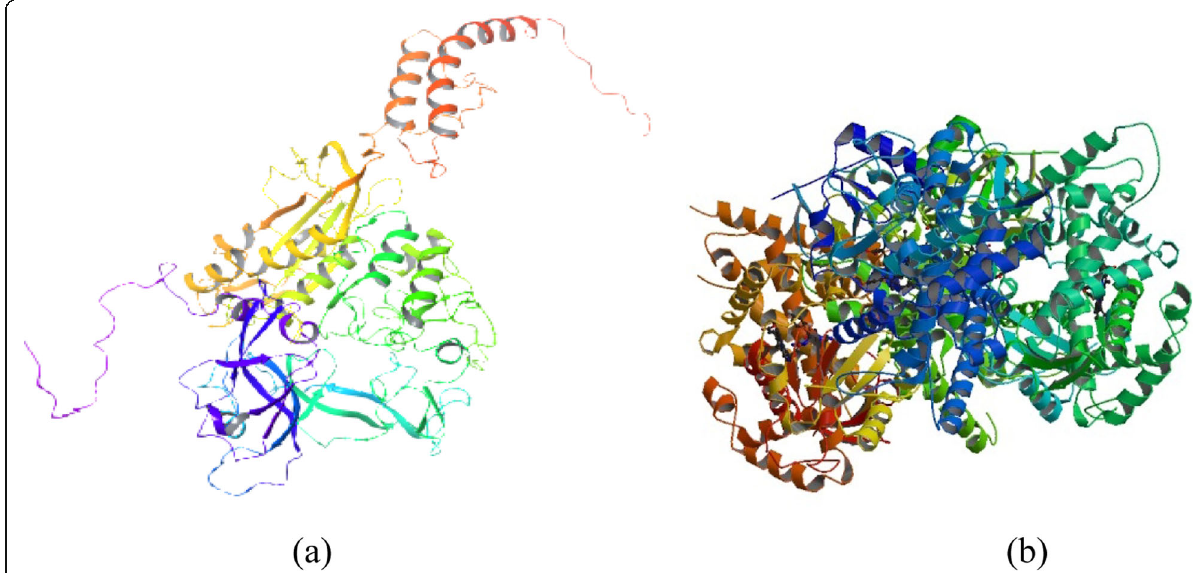
Fig. 2 a 3D structure of Gp63 protein. b 3D structure of CYP51 (Lanosterol 14-alpha demethylase)